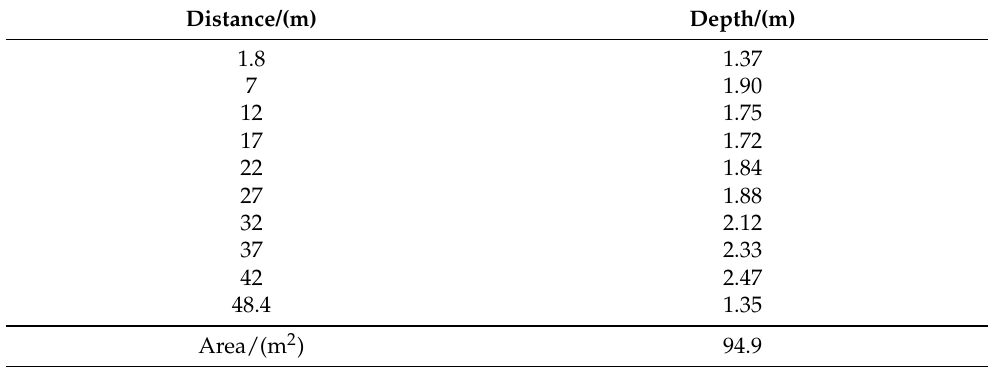
Table 1. Data of the cross-section.